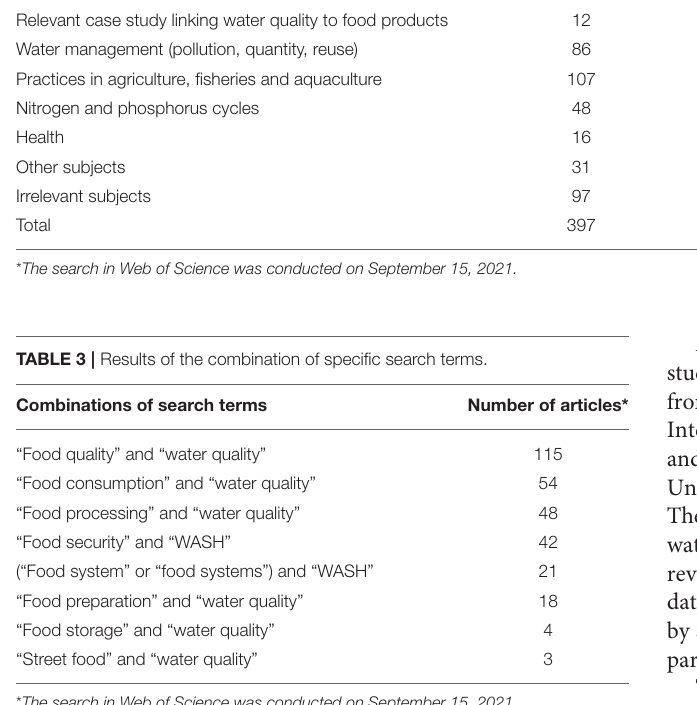
TABLE 2 | Classification of the set of studies. Classification of studies All* Combination of “Water quality” with * Relevant case study linking water quality to food products